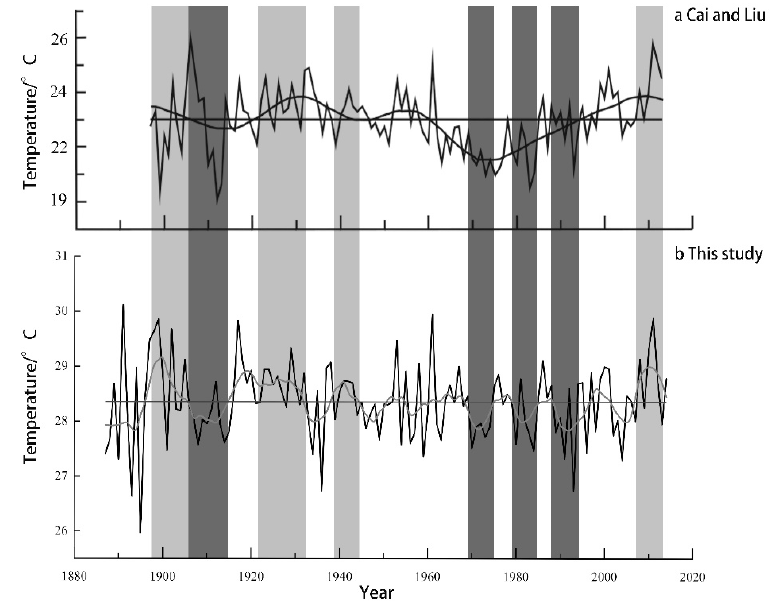
Figure 9. The comparison of the moving average curves of the reconstructed T MJ in this study ( b ) and the reconstructed May–July mean minimum temperature of Cai and Liu ( a ) in the Tongbai Mountains. Dark colors and light colors represent warm periods and cold periods, respectively.